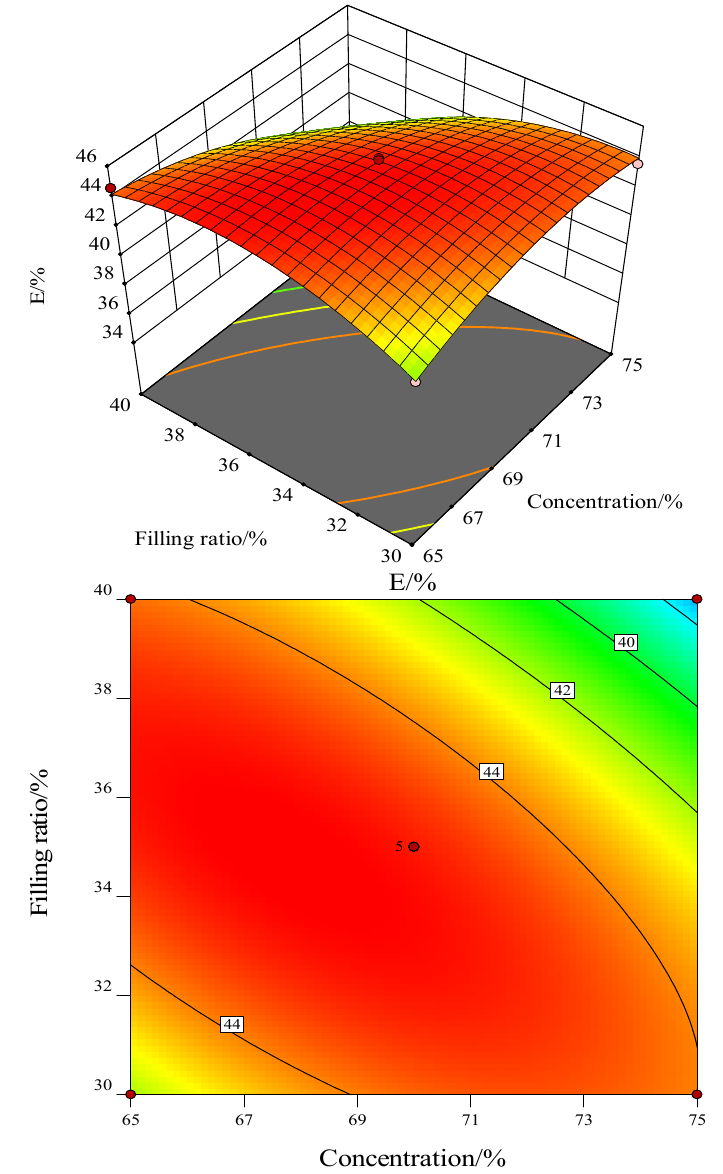
Figure 11. Response surface diagram and contour map at the action of grinding concentration and filling ratio.